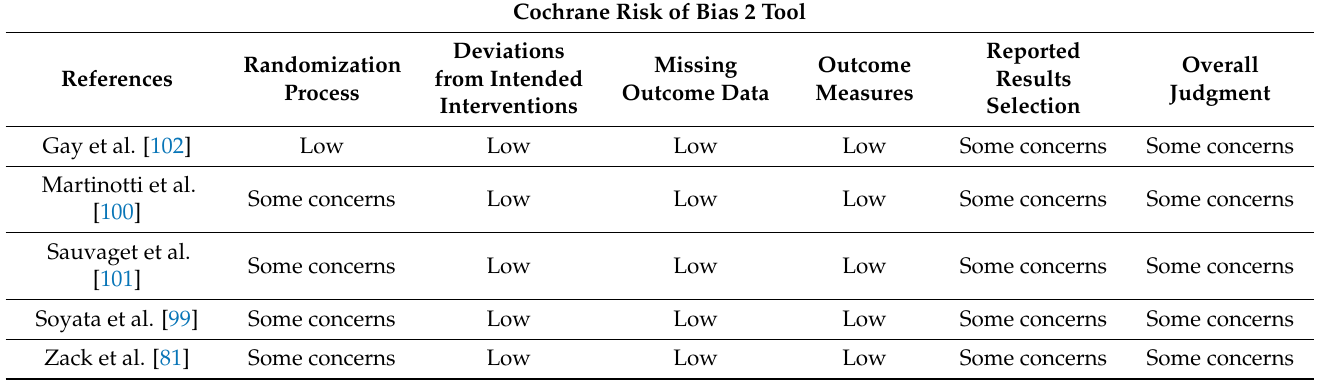
Table 1. Risk of bias assessment related to the papers evaluated through the Revised Cochrane Risk-of-Bias 2